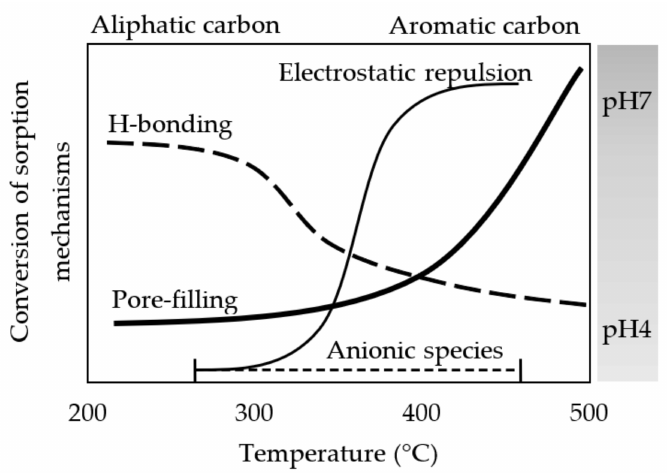
Figure 6. The concept of possible mechanisms for SMX sorption by carbon phases (aliphatic and aromatic carbons) from lignocellulose